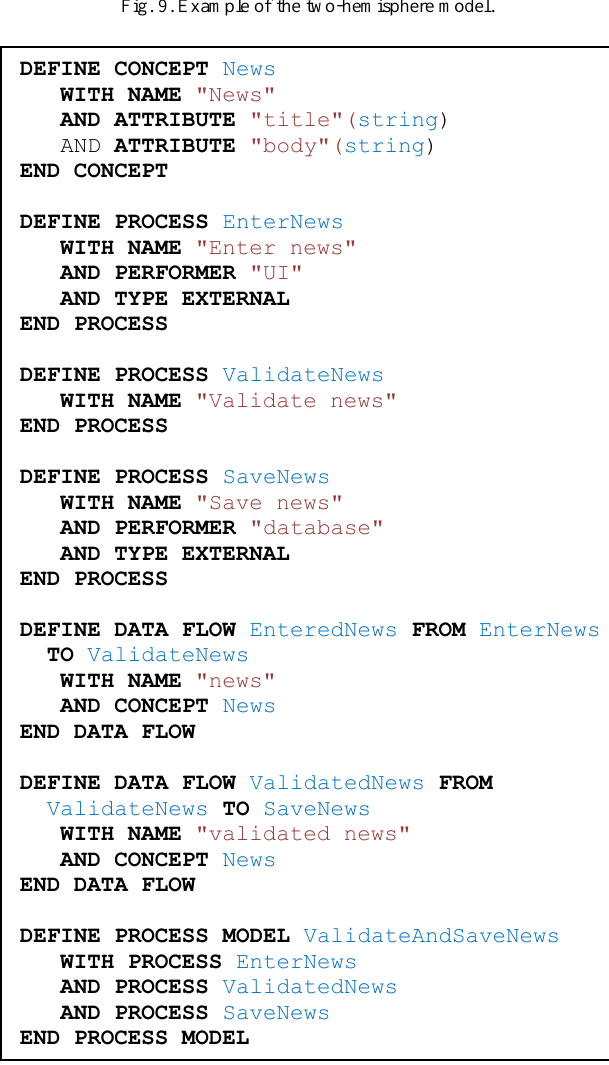
Fig. 9. Example of the two-hemisphere model.